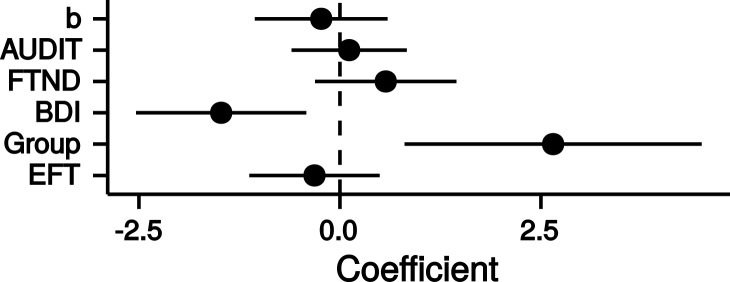
Point estimates and 95% confidence intervals of variables predicting log(k) temporal discounting parameters. b: exponent of the time perception function, AUDIT: Alcohol Use Disorders Identification Test (68), FTND: Fagerström Test for Nicotine Dependence (63), BDI: Beck Depression Inventory (67), Group: healthy control participants vs. pathological gamblers, EFT: mean number of internal details in episodic future thinking. All variables were z-transformed before entering the regression analysis.